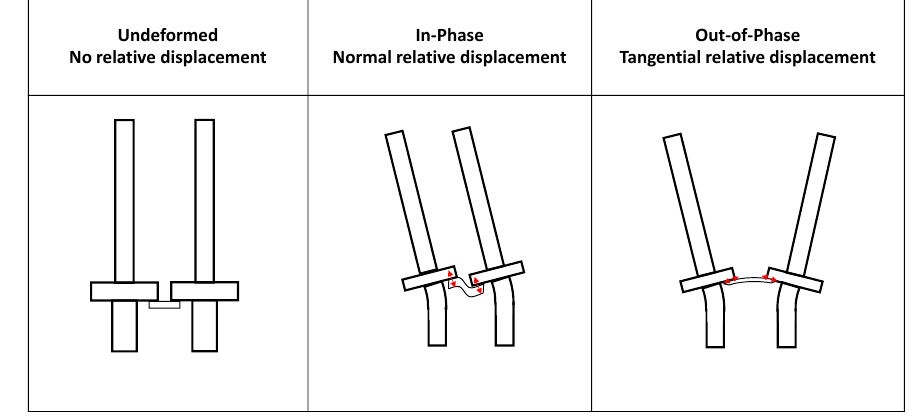
Figure 14. In-phase and out-of-phase behaviors.